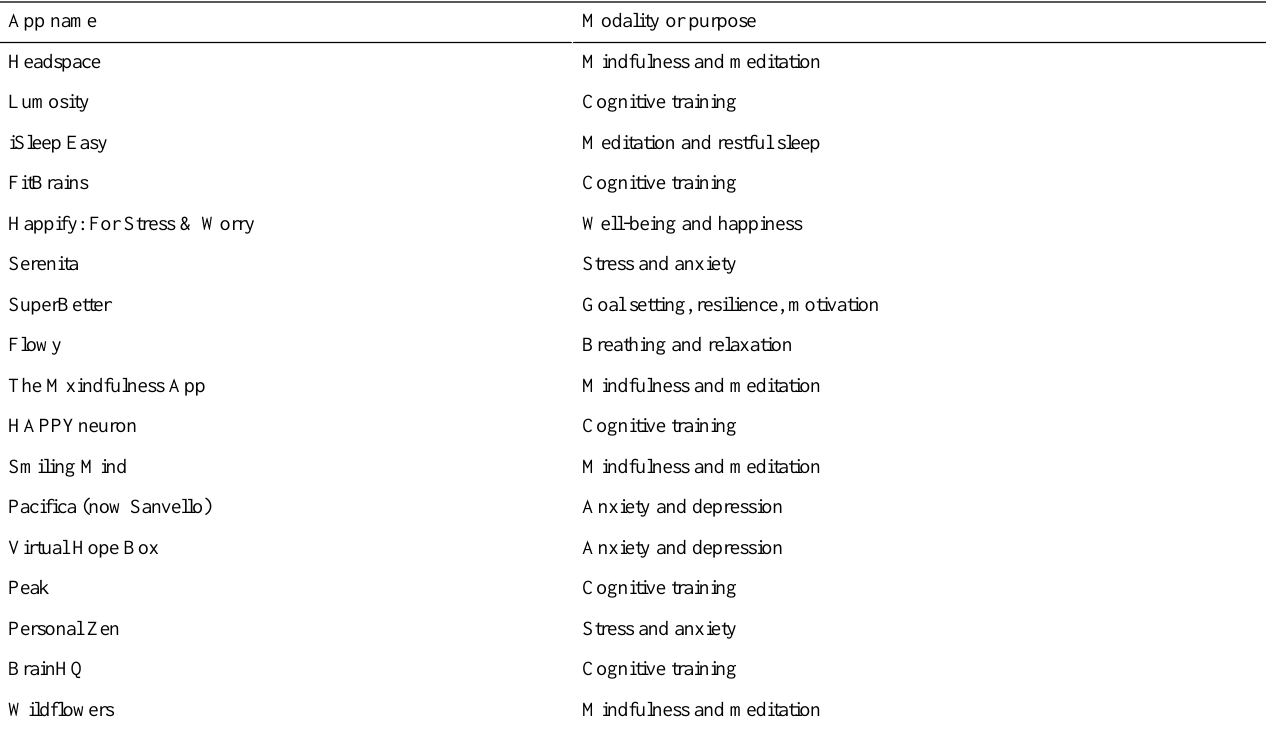
Table 1. List of apps and their modality or